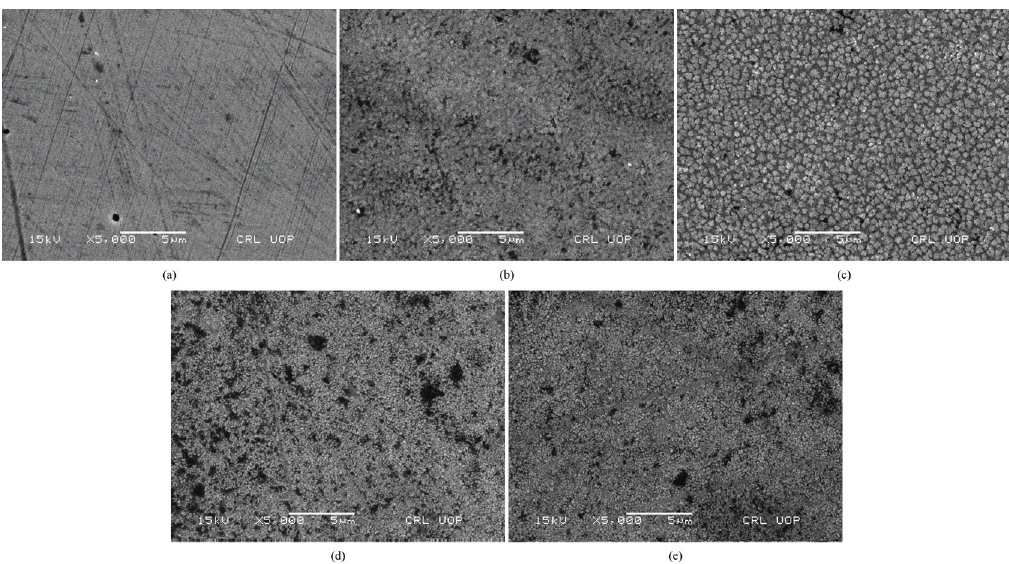
Figure 6. SEM micrographs of high carbon steel samples nitrided for different treatment times (a) untreated (b) nitrided for 1 hour (c) nitrided for 2 hours (d) nitrided for 3 hours (e) nitrided for 4